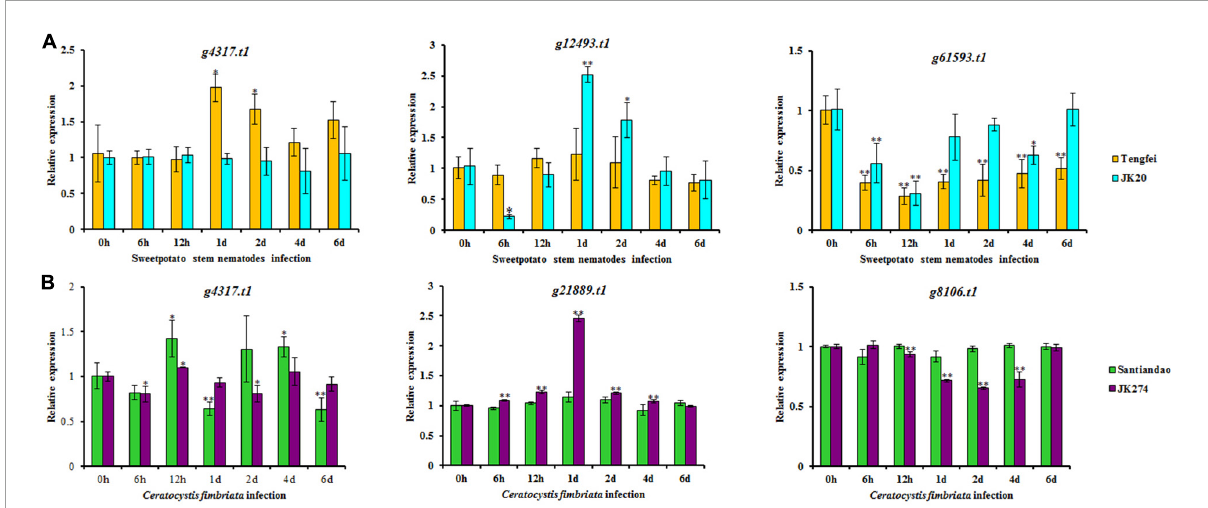
FIGURE9 Expression analysis of nucleotide-binding site (NBS)-encoding genes on the storage roots of sweet potato cultivars or lines. (A) Relative expression levels of g4317.t1 , g12493.t1 , and g61593.t1 in storage roots after different times of stem nematode infection. (B) Relative expression levels of g4317.t1 , g21889.t1 , and g8106.t1 after different times of Ceratocystis fimbriata infection. The significance of DEG levels compared with control were denoted as ∗ < 0.05, ∗∗ <